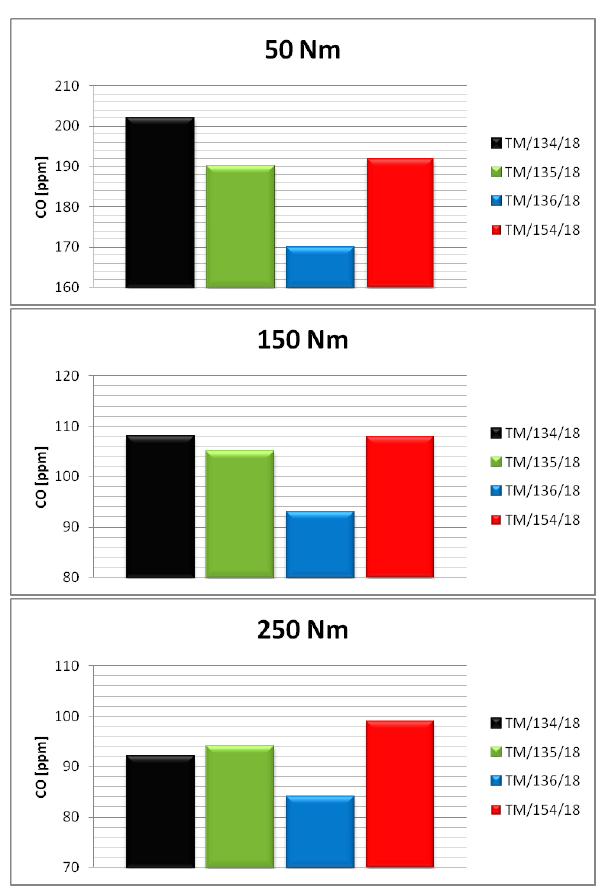
Fig. 5. CO concentration in exhaust gas in selected duty points of the engine for the four tested fuels